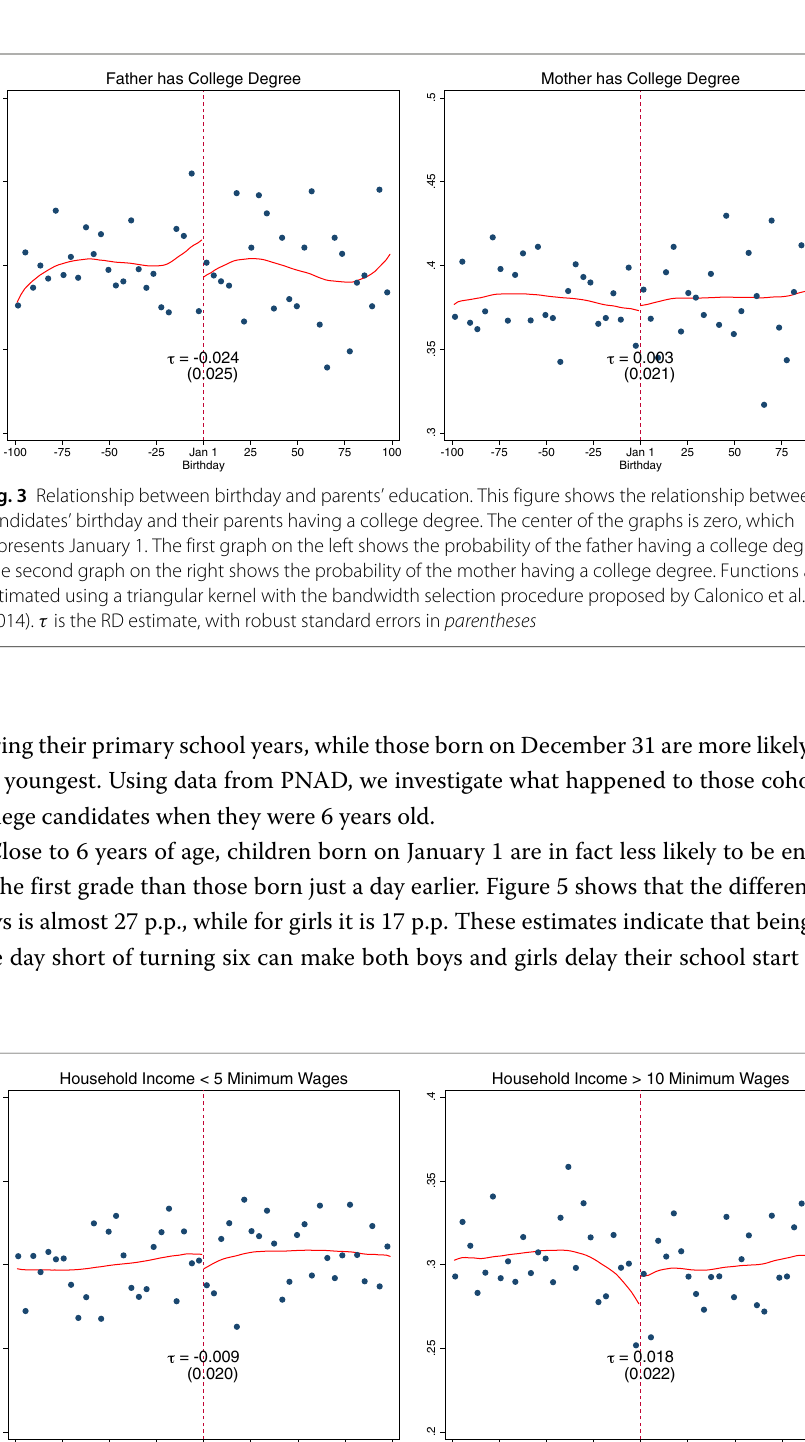
Fig. 4 Relationship between birthday and household income. This figure shows the relationship between candidates’ birthday and their household income by the time of the exam. The center of the graphs is zero, which represents January 1. The first graph on the left shows the probability of the household receiving less than five minimum wages per month. The second graph on the right shows the probability of the household receiving more than ten minimum wages per month. Functions are estimated using a triangular kernel with the bandwidth selection procedure proposed by Calonico et al. (2014). τ is the RD estimate, with robust standard errors in